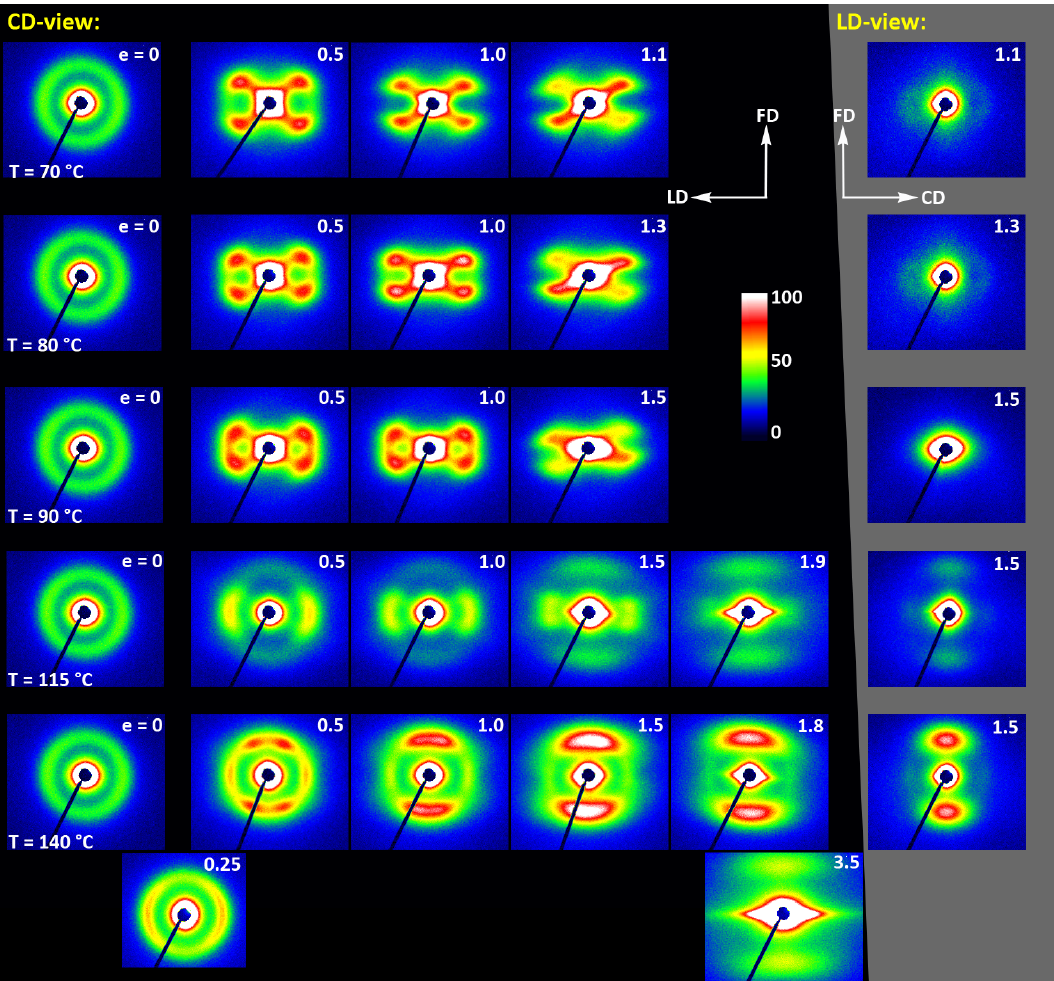
Figure 17. 2D-SAXS patterns of the initially amorphous A samples deformed in the plane-strain compression at temperature T d = 70–90 °C ( rows from top to bottom ), to the indicated true strain. The patterns on the left (black background) were obtained in the CD-view. The patterns in the column on the right (gray background) are LD-view.